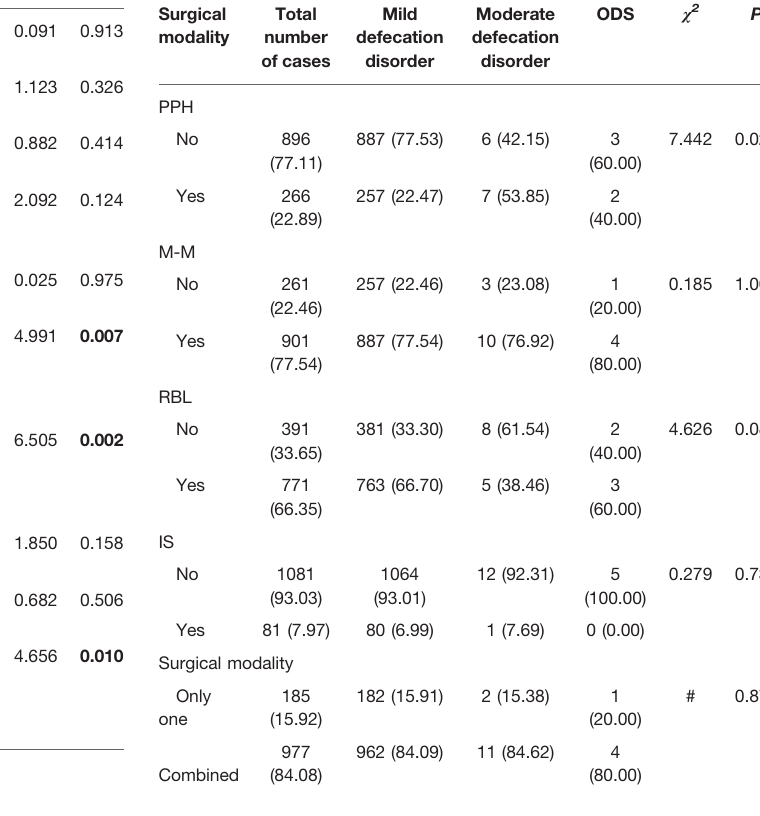
TABLE 4 | Correlation between surgical modality and defecation